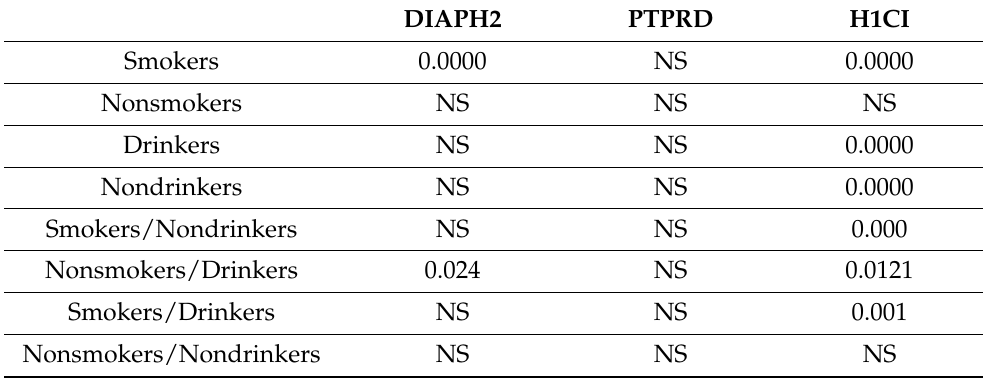
Table 6. Comparison of alleles distribution between the case and the control